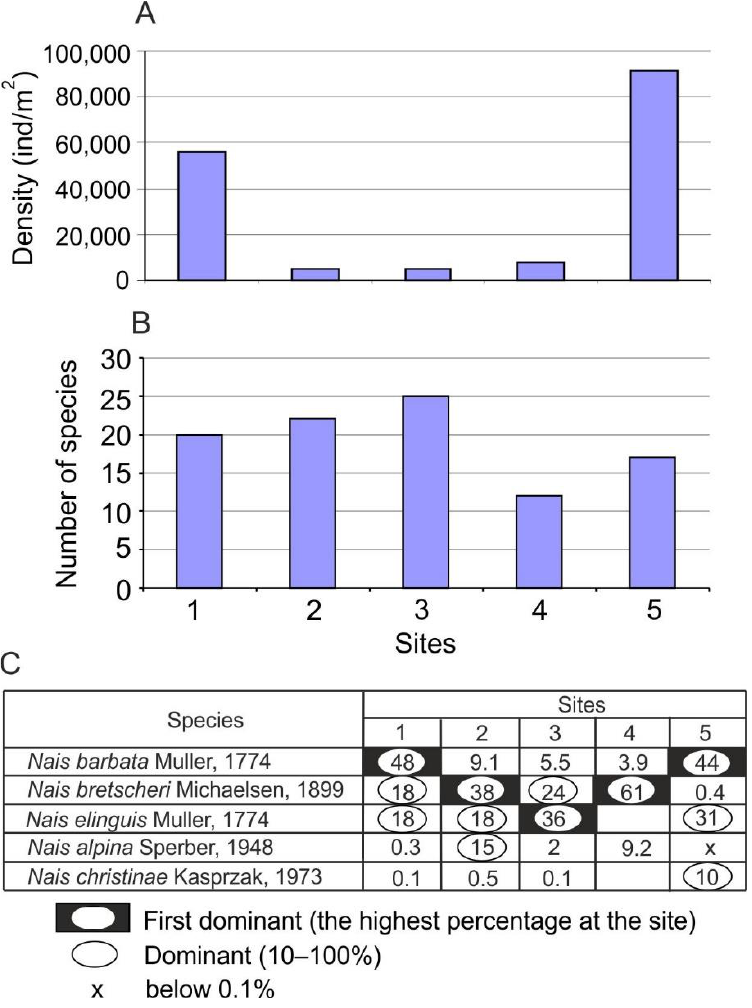
Figure 5. The density ( A ), number of species ( B ), and percentage of dominant species ( C ) of Oligochaeta in the Dunajec River in 1992 – 1993 (sites 1 – 3) and 1999 (sites 4 – 5) (according to [18,26],